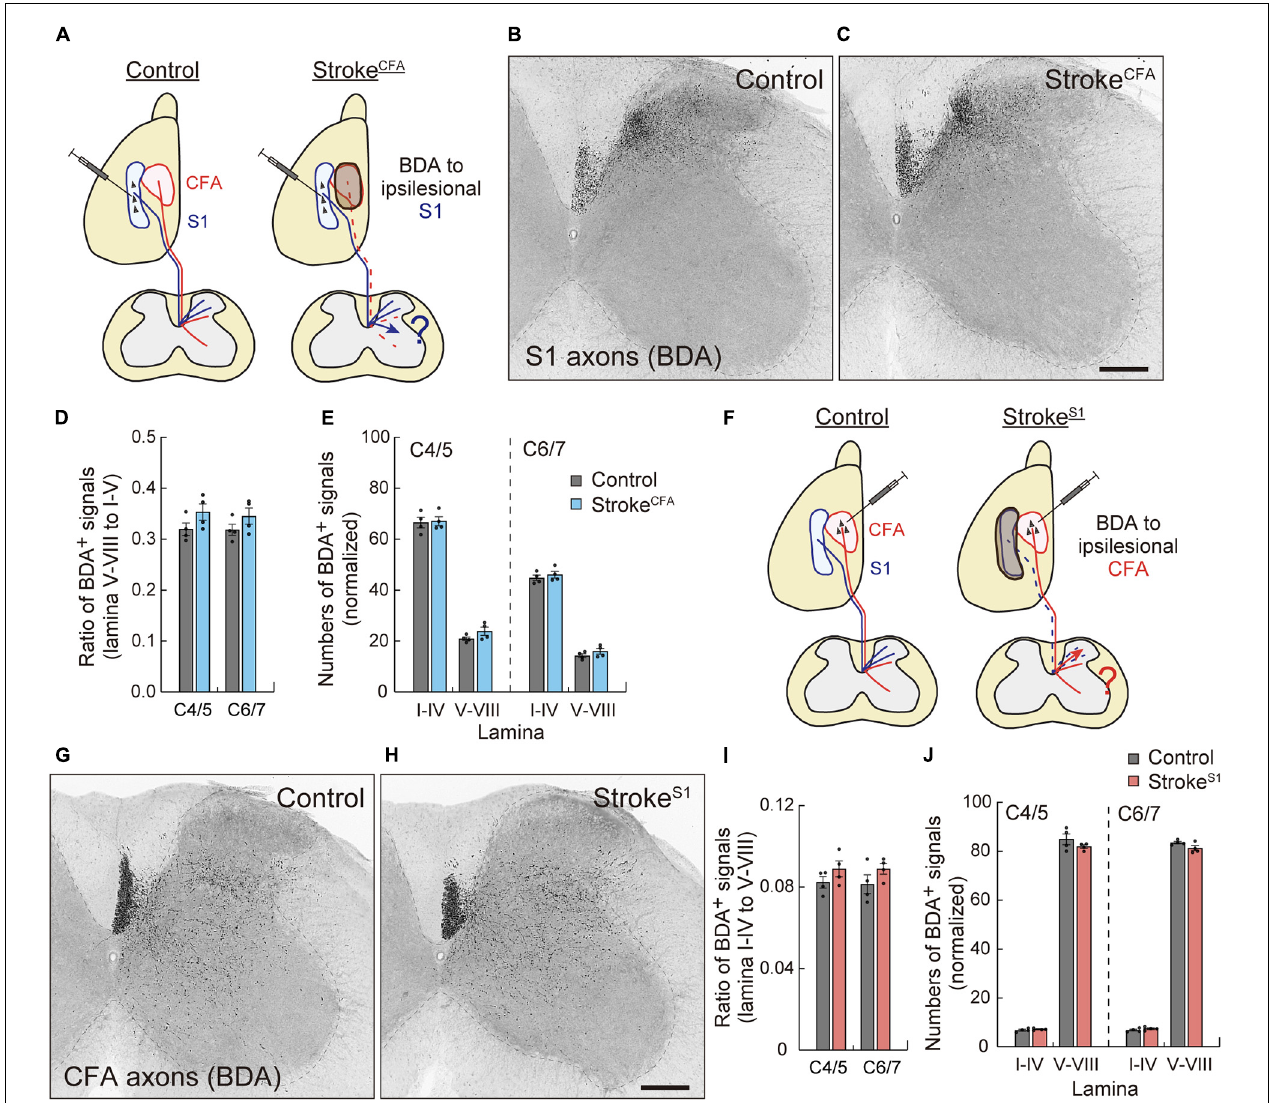
FIGURE 5 | Motor and sensory CST axons are not compensatorily rewired in the stroke of S1 and CFA. (A) Experimental diagram of the anterograde tracing of CST from ipsilesional S1 in stroke CFA . The dotted lines indicate degenerated motor CST axons. (B,C) Representative images of BDA-labeled ipsilesional sensory CST axons in the cervical spinal cord (C5) of control (B) and stroke CFA animals (C) . (D) The ratio of the axonal density of ipsilesional sensory CST fibers in the medioventral laminae V–VIII to the dorsal laminae I–IV. F ( 1 , 12 ) = 4.691 p = 0.0512, two-way ANOVA; p = 0.2283 (C4/5), p = 0.3981 (C6/7), Bonferroni post hoc test. (E) The axonal density of ipsilesional sensory CST fibers in the indicated laminae at C4/5 and C6/7. F ( 1 , 24 ) = 2.786, p = 0.1081, two-way ANOVA; p > 0.9999 (lamina I–IV of C4/5 and C6/7, lamina V–VIII of C6/7), p = 0.5789 (lamina V–VII of C4/5), Bonferroni post hoc test. (F) Experimental diagram of anterograde tracing of ipsilesional motor CST in stroke S 1 . (G,H) Representative images of BDA-labeled ipsilesional motor CST axons in the cervical spinal cord (C5) of control (G) and stroke S 1 animals (H) . (I) The ratio of the axonal density of ipsilesional motor CST fibers in the dorsal laminae I–IV to the medioventral V–VIII. F ( 1 , 12 ) = 3.860, p = 0.0730, two-way ANOVA; p = 0.4423 (C4/5), p = 0.3252 (C6/7), Bonferroni post hoc test. (J) The axonal density of ipsilesional motor CST fibers in the indicated laminae at C4/5 and C6/7. F ( 1 , 24 ) = 2.678, p = 0.1148, two-way ANOVA; p > 0.9999 (lamina I–IV of C4/5 and C6/7), p = 0.1403 (lamina V–VIII of C4/5), p = 0.4001 (lamina V–VIII of C6/7). N = 4. Scale bars, 200 µ